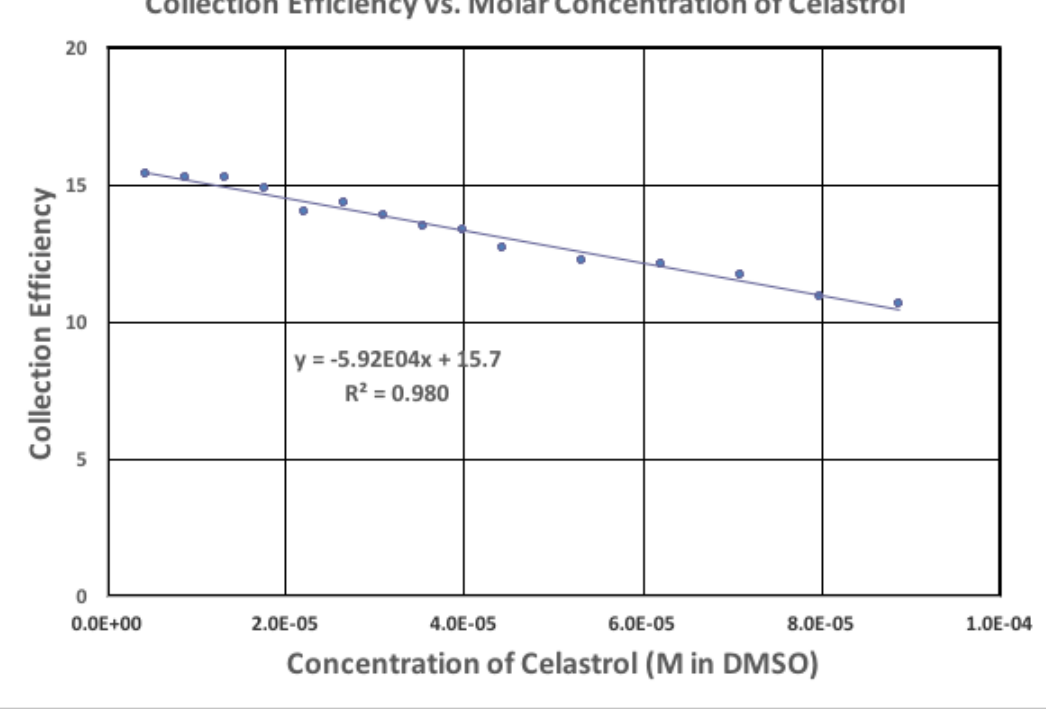
Figure 5. Collection efficiency of celastrol.